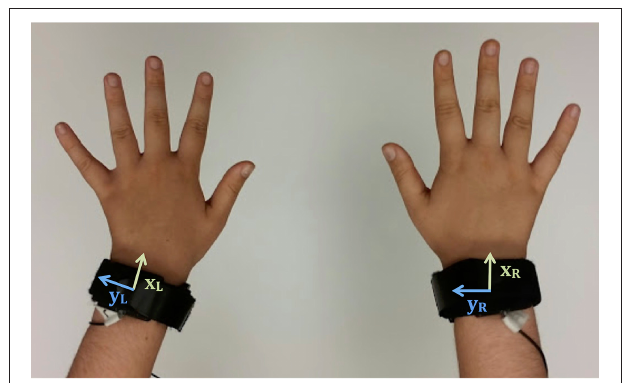
FIGURE 1 | A plastic housing and integrated strap securely attach each inertial measurement unit to the user’s wrist. The individual whose hands are shown in this image provided written consent for this image to be